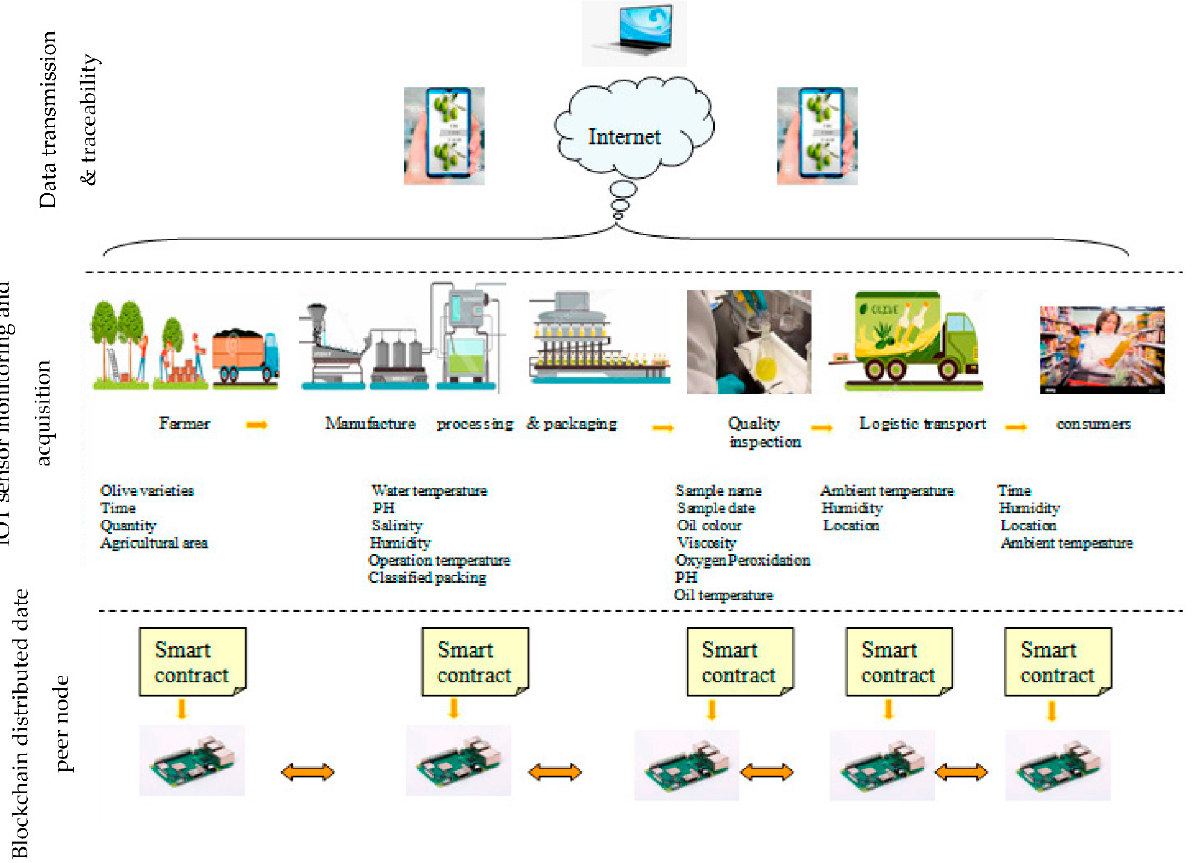
Figure 4. Global